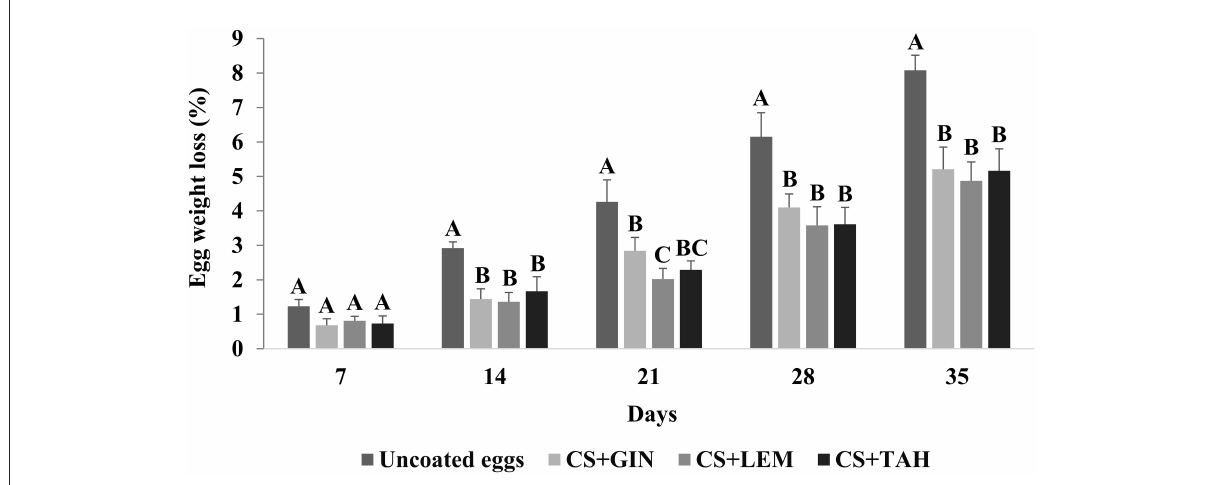
FIGURE4 Egg weight loss (%) of the different treatments during the 35 days of storage at 20 ◦ C. (A–C) Means with different uppercase letters differ significantly ( P < 0.05). CS + GIN, cassava starch + Ginger essential oil; CS + LEM, cassava starch + Lemongrass essential oil; CS + TAH, cassava starch + Tahiti lemon essential oil.